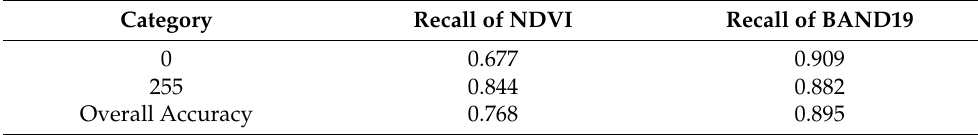
Table 13. Quantitative comparison results of vegetation extraction from the Pavia university data